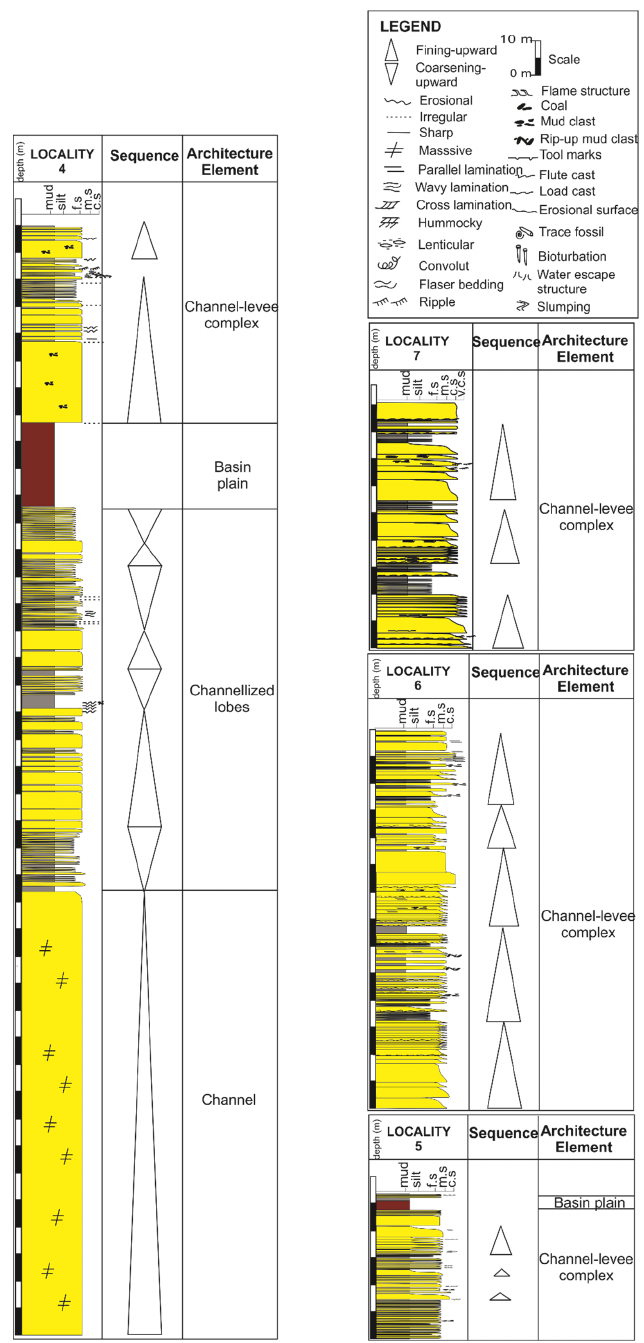
Figure 7. Sedimentary log of L4 to L7, north region of the northwest Crocker Formation.